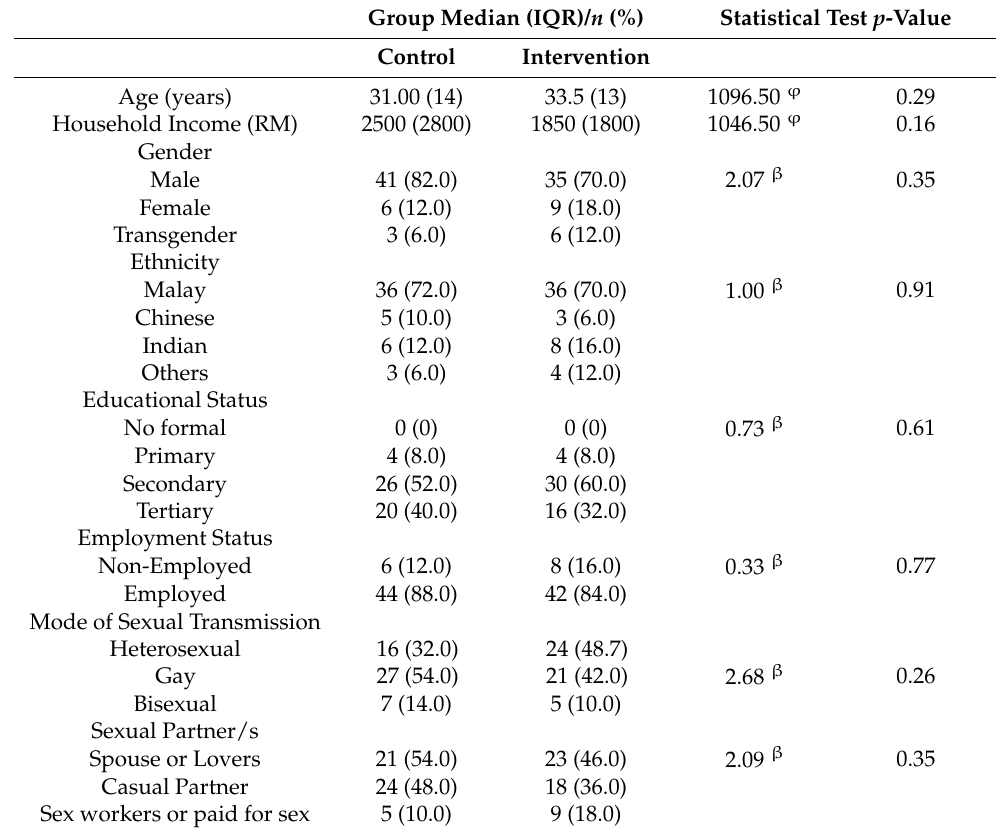
Table 1. Baseline sociodemographic and sexual characteristics ( n =